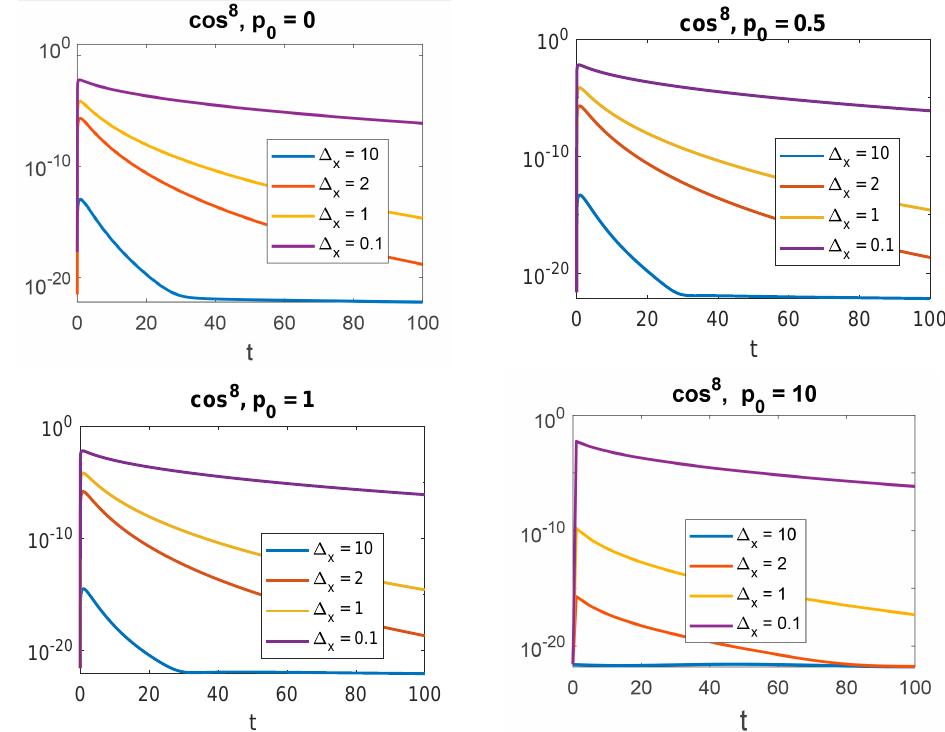
Figure 3. Fraction of the probability density lying outside the light cone for an initial wavepacket ψ ( 0, x ) [Equation (19)] with f ( x ) = cos 8 x / ∆ x , where ∆ x and p 0 vary as indicated. Figures 4 and 5 display similar results but for an initial wavefunction ψ f ( 0, x ) with f ( x ) = cos 2 ( x / ∆ x ) and f ( x ) = 1, respectively, (only the case with initial average momentum p 0 = 0 is shown). Note that we have taken a higher value for the numerical 0, given that the momentum range over which we need to integrate in Equation (21), for each value of t , is significantly more extended than with a cos 8 ( x / ∆ x ) function. Finally, Figure 6 compares the probability density propagating beyond the light cone for the three functions f ( x ) we have considered in this paper (with the same initial compact support and mean